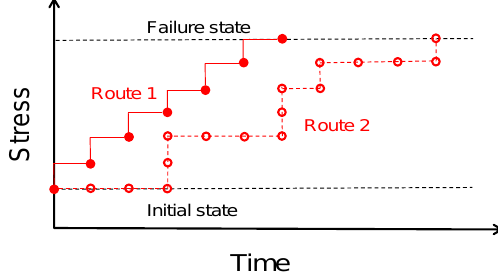
Figure 3. Schematic diagram illustrating the negative binomial model; between the two stress states, many “stress routes” can be present, and the probability of each route can be estimated with the model, then the probability distribution for the interval between two consecutive events can be